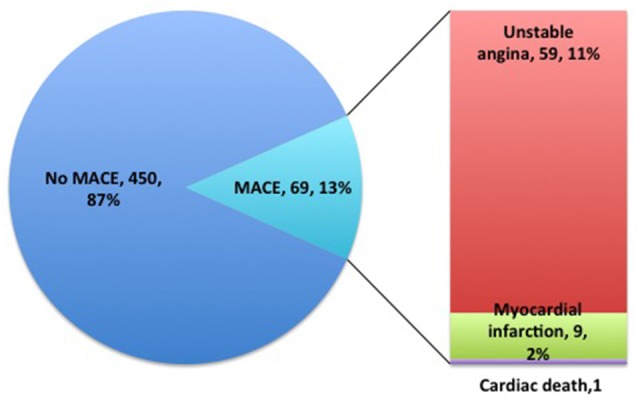
One-year follow-up clinical outcome distributions of clopidogrel-treated patients after PCI.